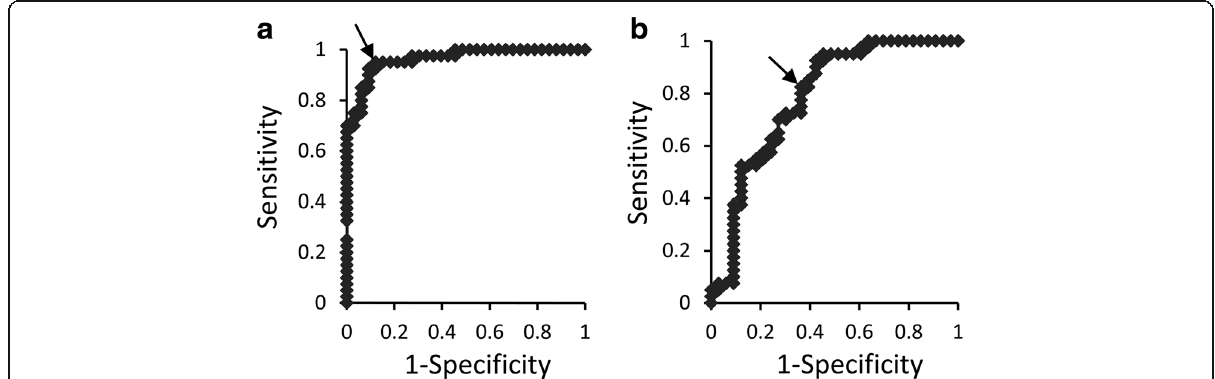
Fig. 5 ROC analyses of PICF calprotectin and NTx to predict peri-implant diseases. PICF samples were collected from sites with and without peri- implant diseases ( n = 74). Calprotectin ( a ) and NTx ( b ) amounts in PICF samples were subjected to ROC curve analysis. AUC values for calprotectin and NTx amounts were 0.964 (95% CI = 0.913 – 0.996, P < 0.001) and 0.784 (95% CI = 0.672 – 0.891, P < 0.001), respectively, when cutoff values were 60.4 ng/site (arrow in a ) and 1.88 ng/site (arrow in b